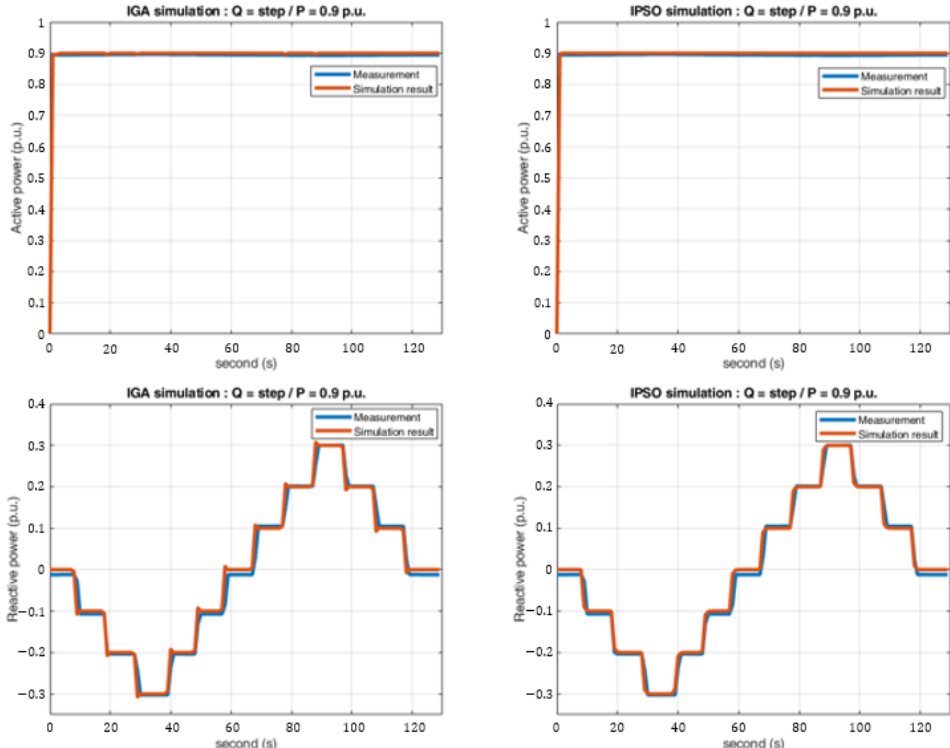
Figure 20. The IGA ( left ) and IPSO ( right ) fitting results .